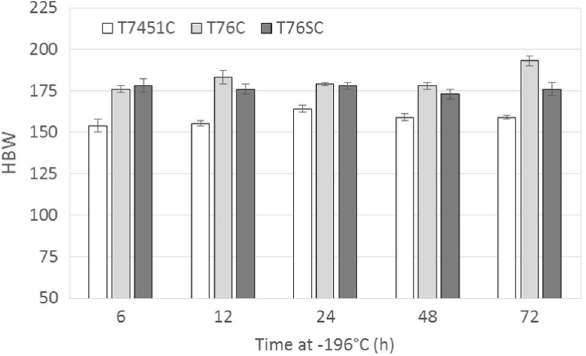
Fig. 5 Influence of soaking time at − 196 °C on